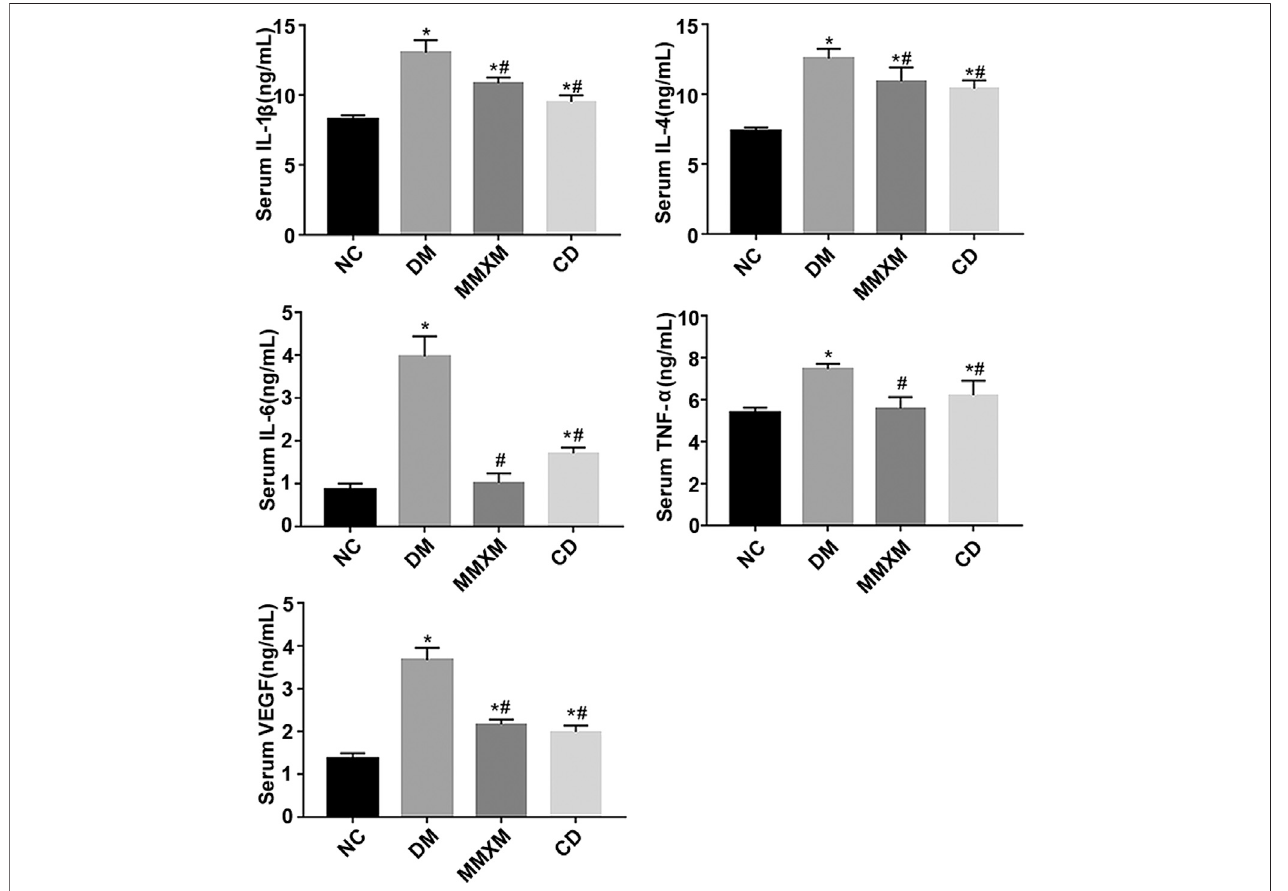
FIGURE 7 | Serum IL-1 β , IL-4, IL-6, TNF- α , and VEGF levels.* p < 0.05 vs. NC; # p < 0.05 vs. DM.